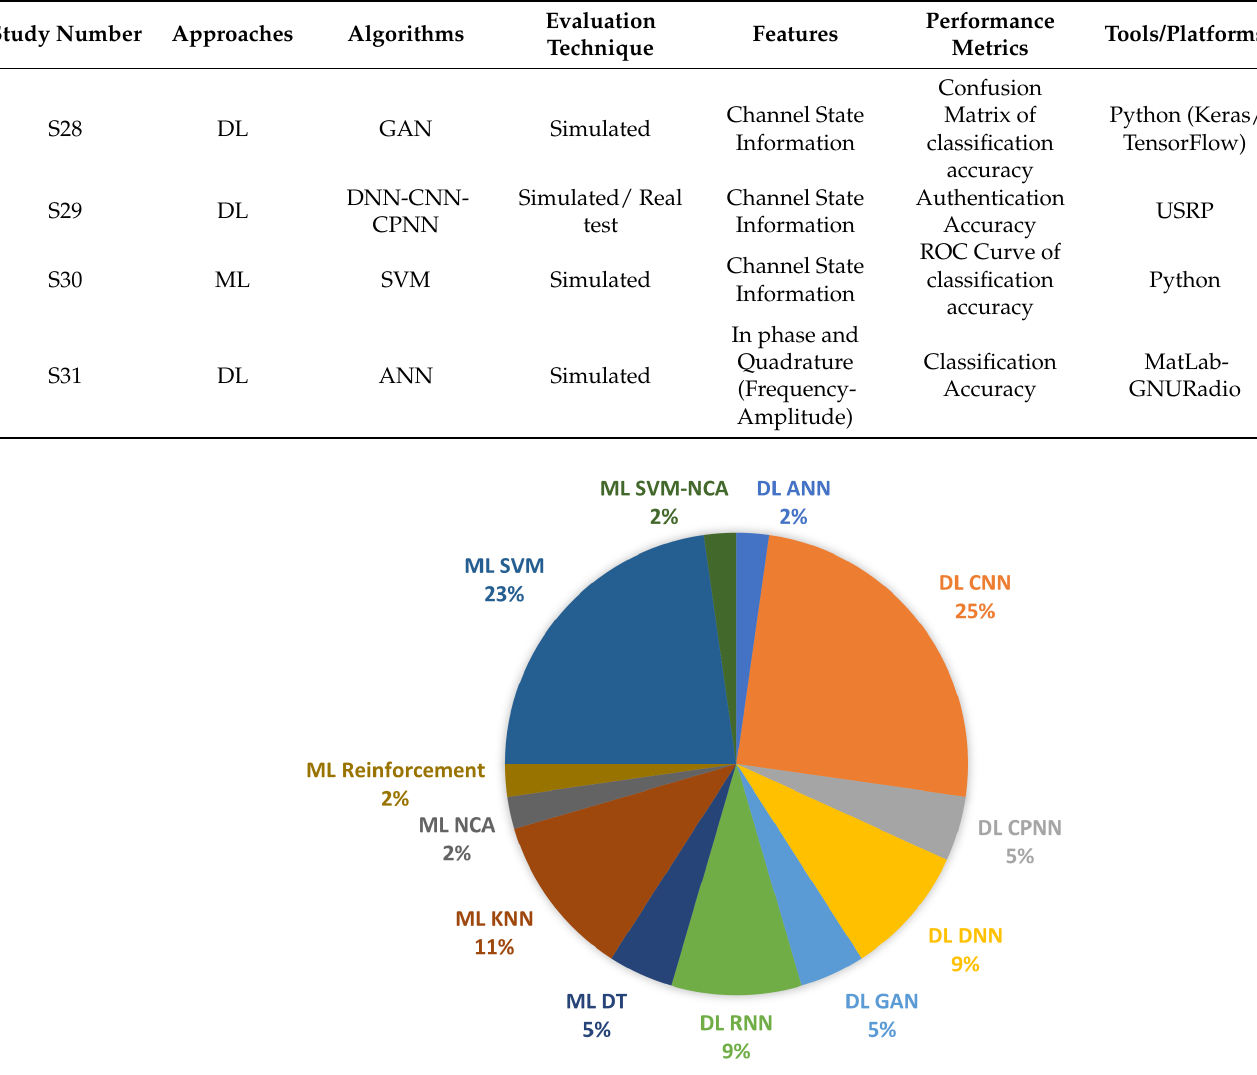
Figure 7. Distribution by type.